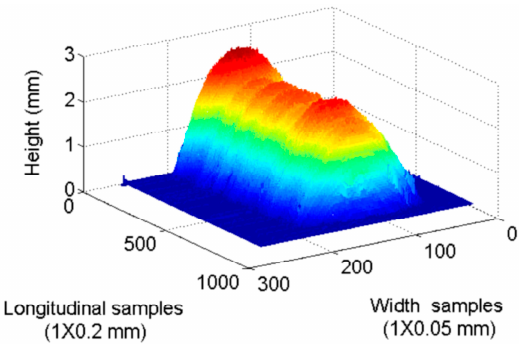
Figure 16. 3D reconstruction of weld bead for a work point of 21 V and 6 m/min.